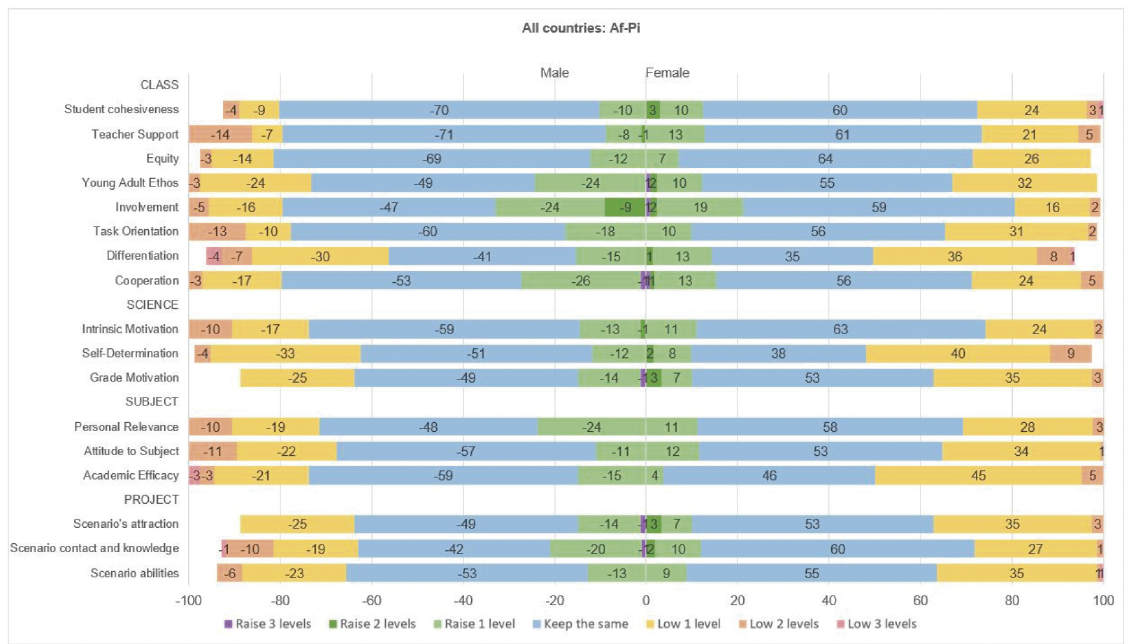
Figure 6. Differences between the actual final situation (Af) and the intended result at the start of the project (Pi) for all participating students